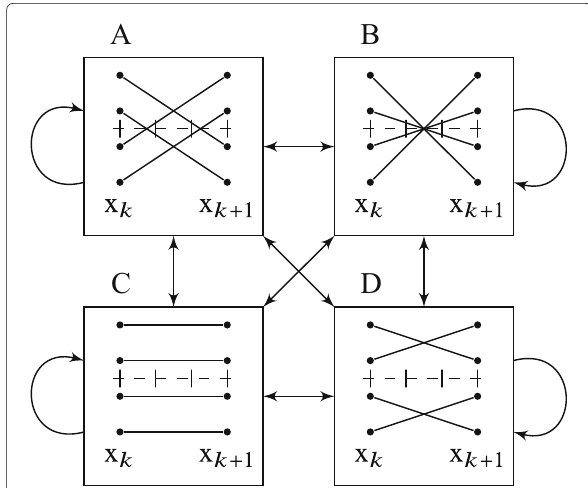
Fig. 2 State machine for unconstrained 4-ASK symbol